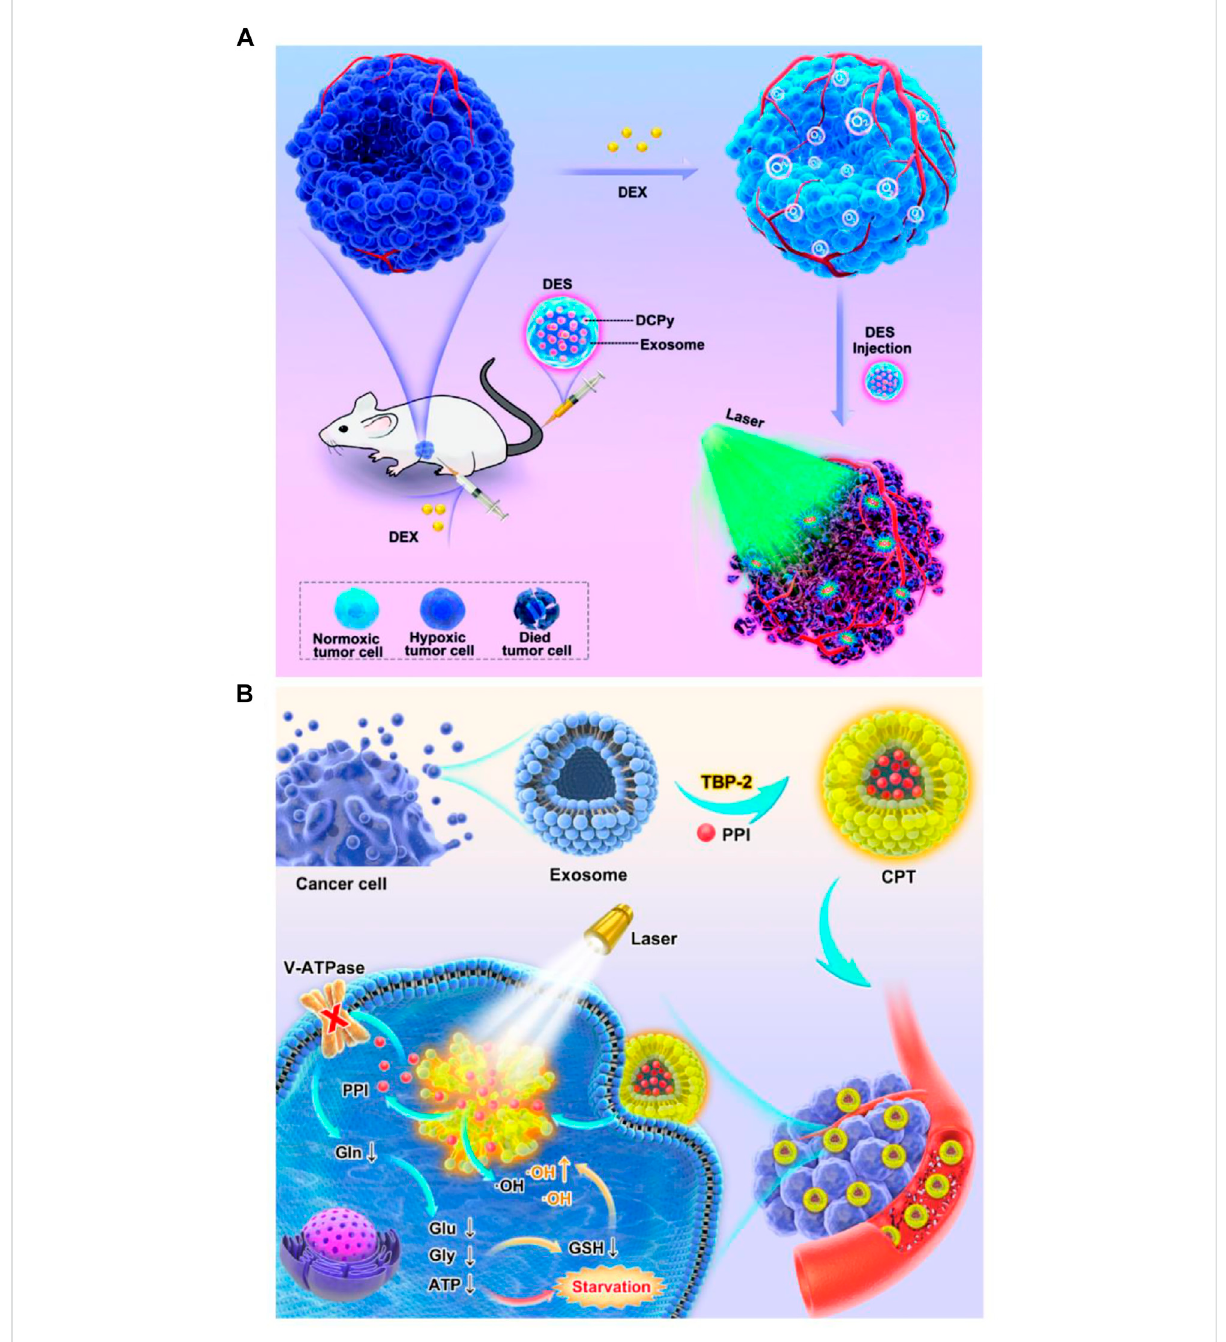
FIGURE 4 Engineered multi-functional EV delivery platforms for photodynamic therapy. (A) Illustration of AIEgens-loaded EV delivery system for promoting ef fi cient tumor penetration and photodynamic therapy (Zhu et al., 2020). (B) Schematic illustration of tumor-derived EVs co-delivering AIEgens and proton pump inhibitors for tumor glutamine starvation therapy and enhanced type-I PDT (Zhu et al., 2022). Copyright 2022 German Chemical Society and